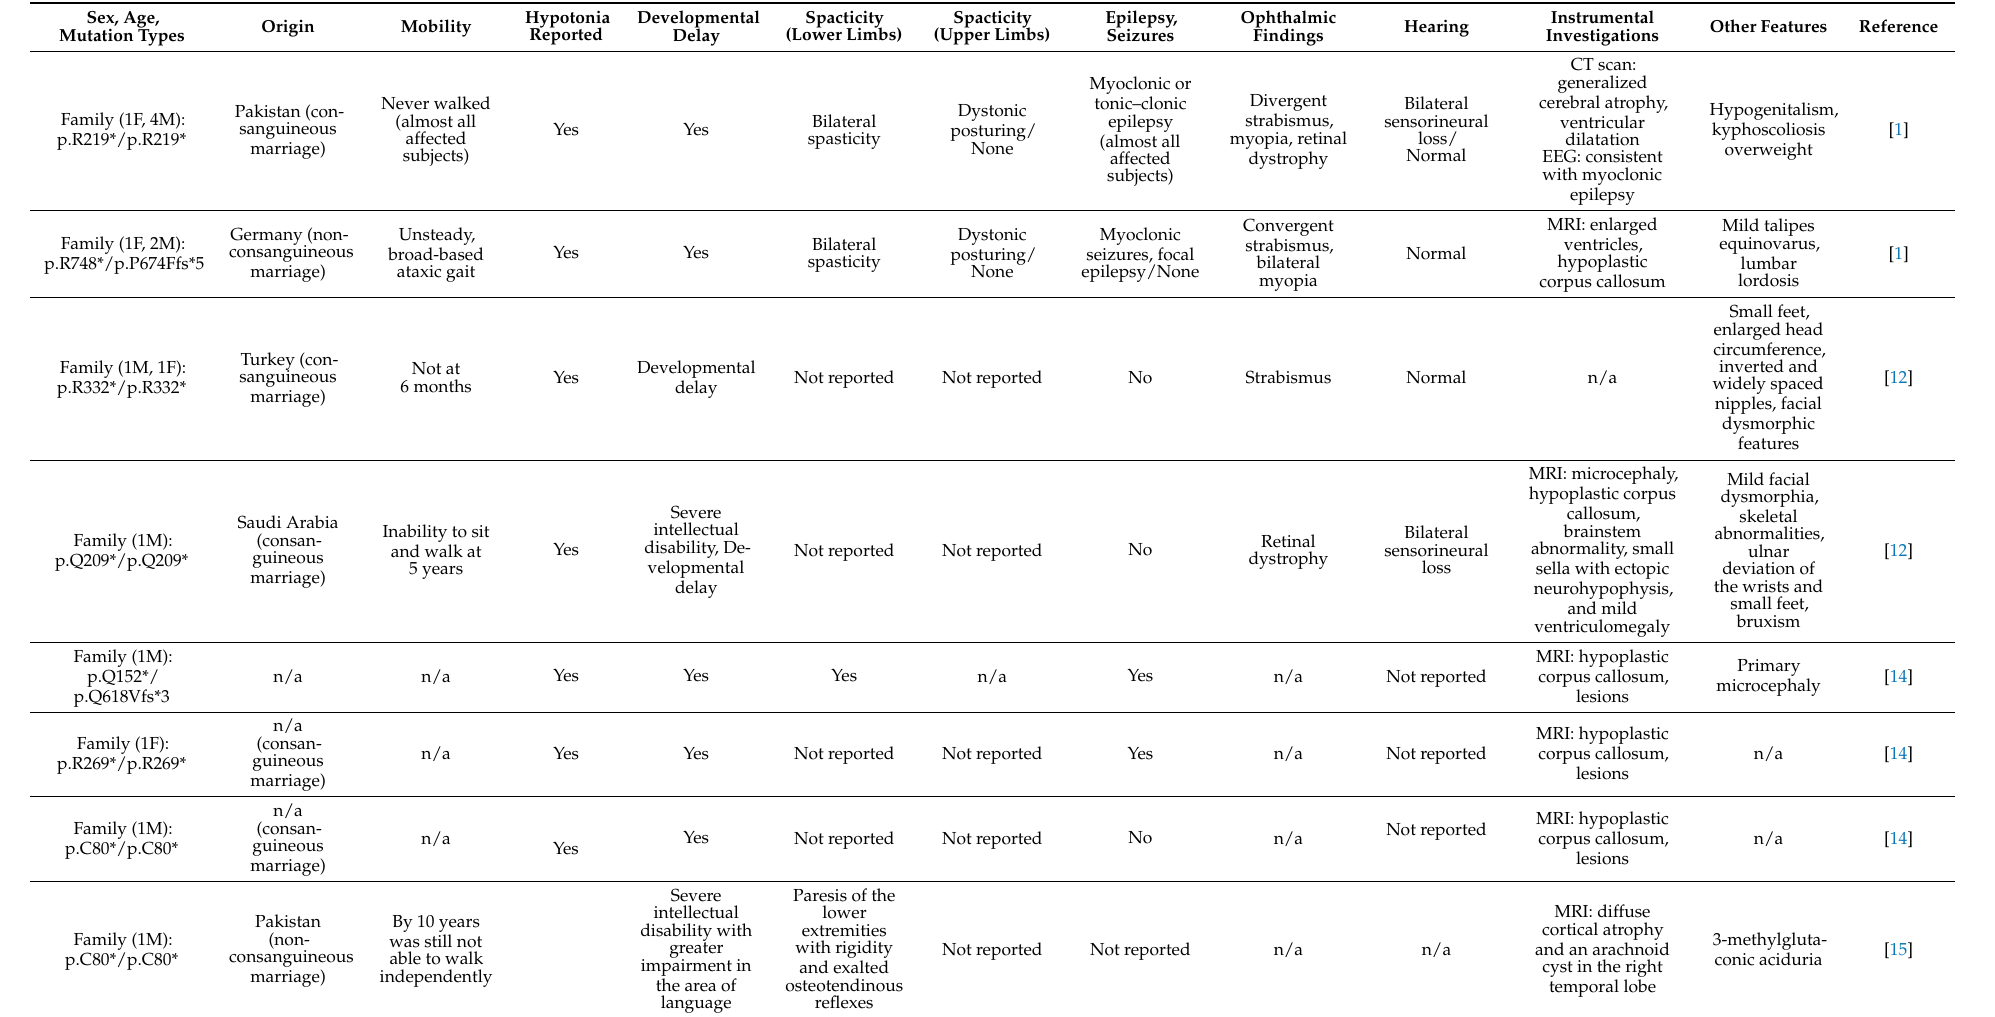
Table 1. Clinical of the affected individuals with biallelic HACE1